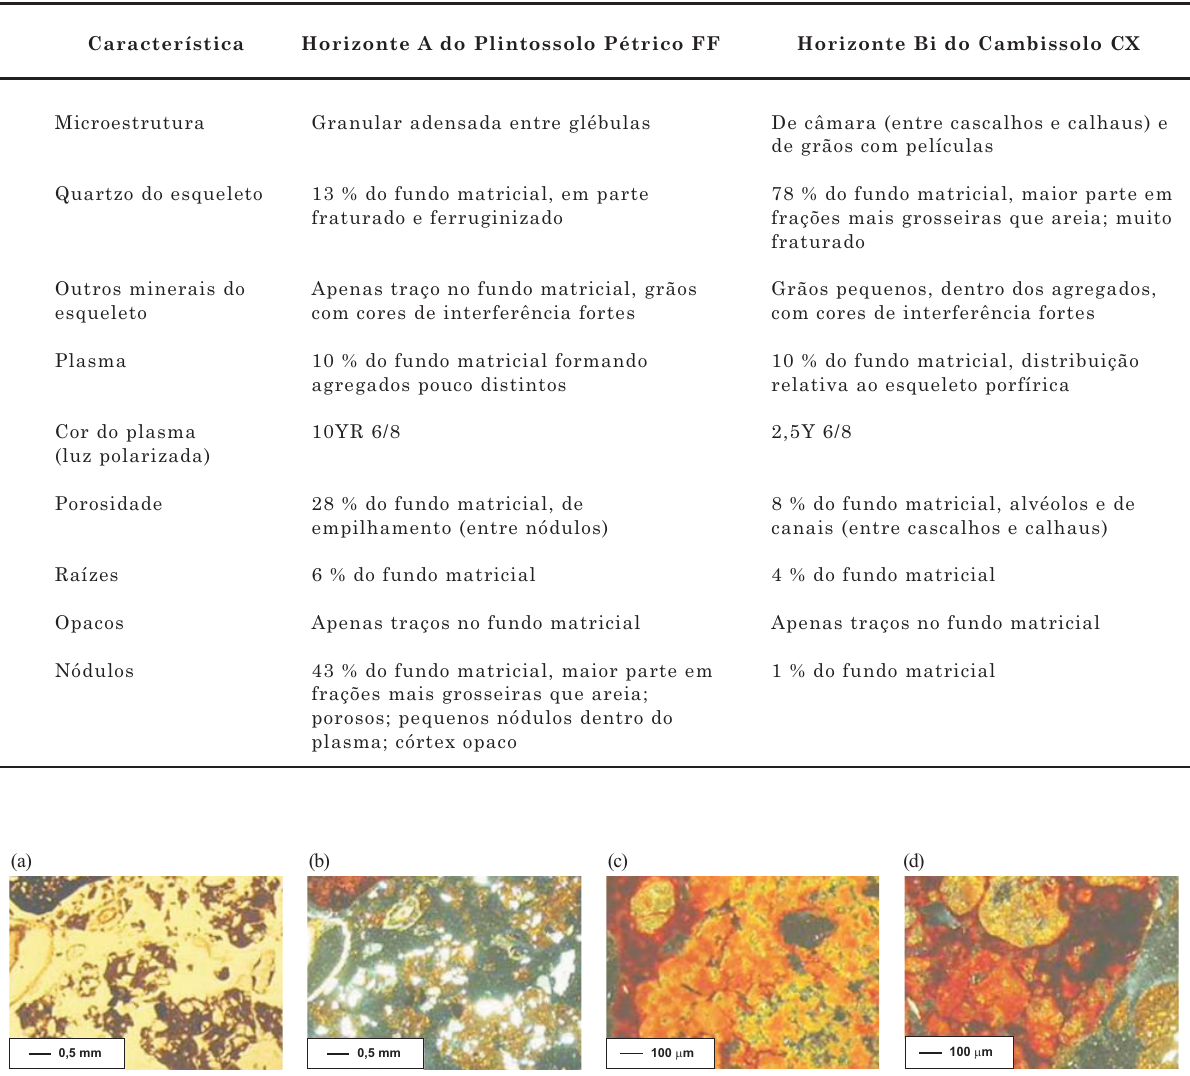
Figura 4. Micrografias do horizonte A do Plintossolo Pétrico Concrecionário distrófico típico – leste de Goiás (FF1). (a) espaço entre nódulos, apresentando-se muito poroso, com muito quartzo e pouco plasma e com fragmentos de raiz; (b) idem anterior, sob nicóis cruzados, onde se observa melhor a